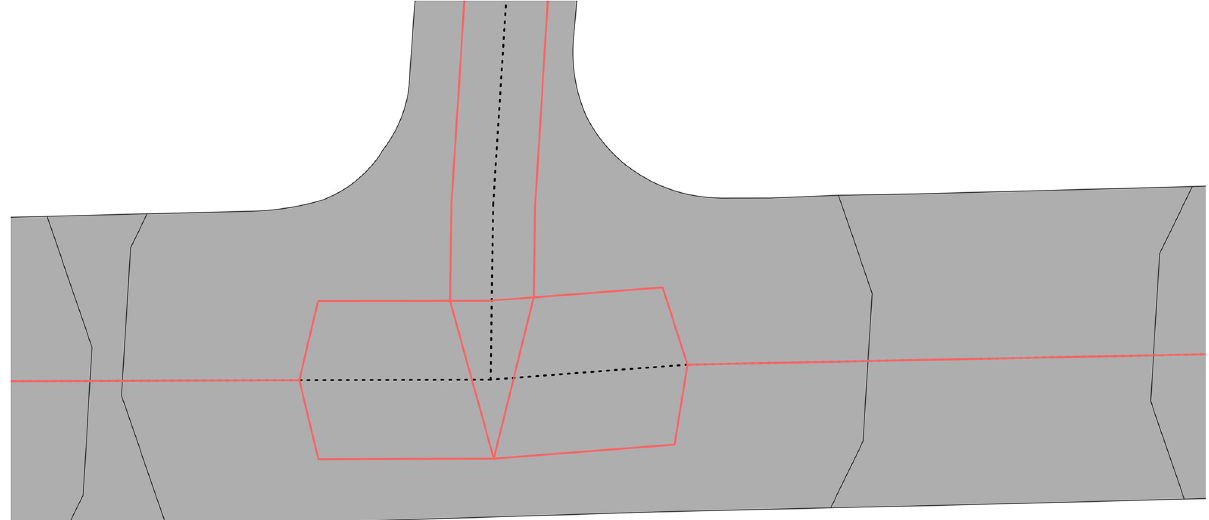
Fig 15. A false “roundabout” generated based on the impact of the road width tolerance.